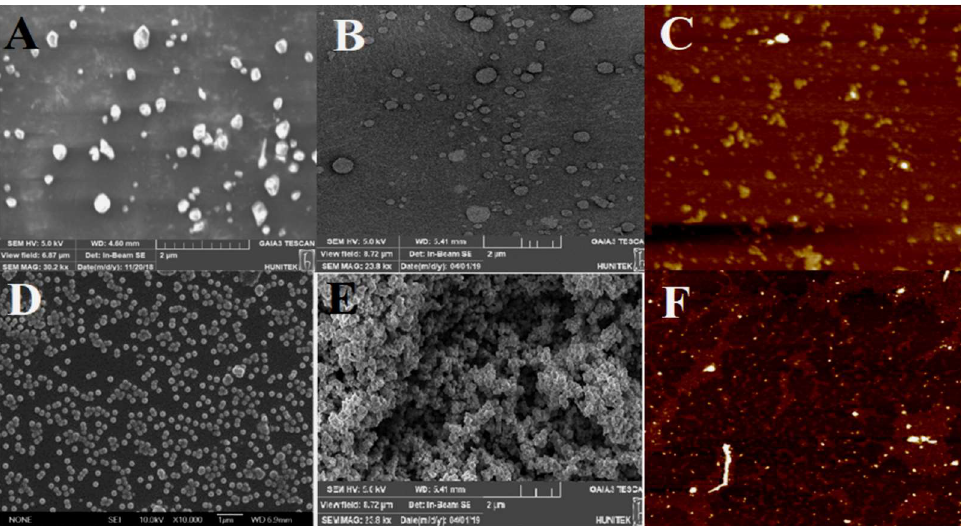
Figure 5. SEM images of synthesized silica nanoparticles for ( A ) amorphous NS barley; ( B ) amorphous NS wheat; ( C ) AFM results for NS barley; ( D ) magnetic NS barley; ( E ) hydrophobic NS barley; and ( F ) AFM results for NS wheat. Table 1. Characterization results of nanoparticles from different sources.